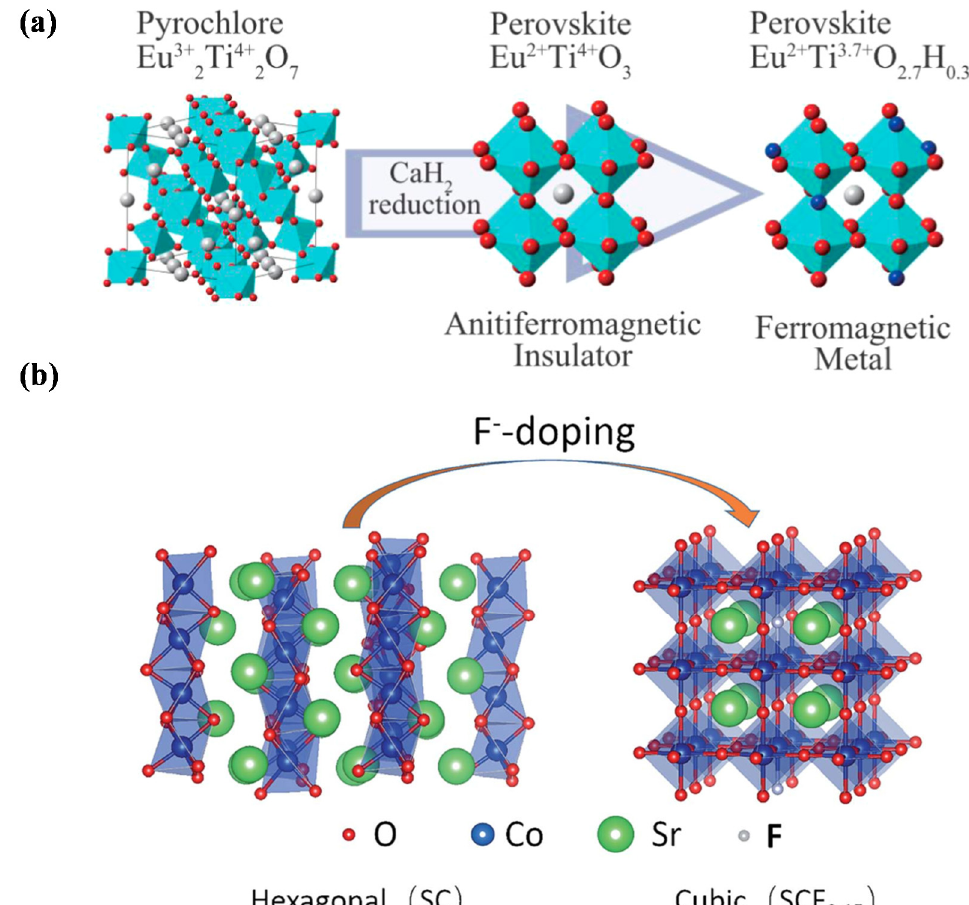
Figure 9. ( a ) The oxyhydride perovskite EuTiO 3 − x H x (× ≤ 0.3) prepared by a low temperature CaH 2 reduction of pyrochlore Eu 2 Ti 2 O 7 and perovskite EuTiO 3 . Reproduced with permission from ref. [116], Copyright 2015, American Chemical Society. ( b ) Schematic presentation of the structural transition from the hexagonal structure to the cubic structure. Reproduced with permission from ref. [120], Copyright 2019, Royal Society of Chemistry.